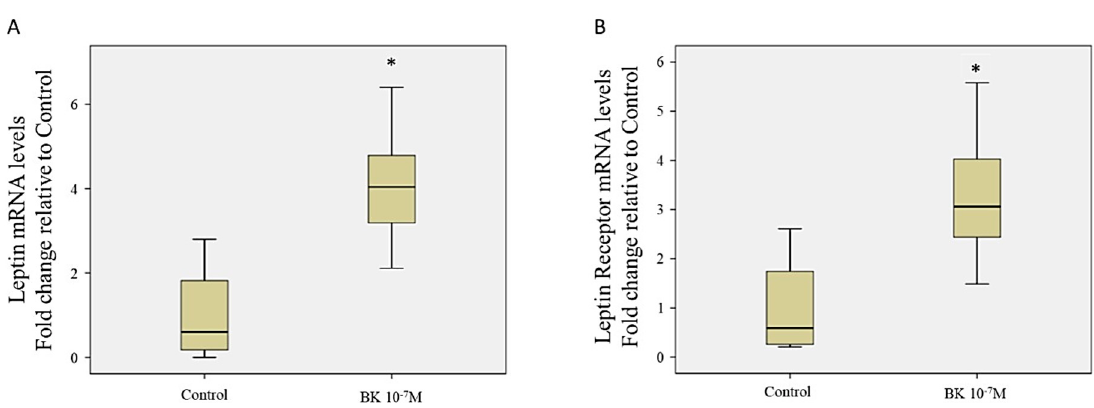
Figure 4. Assessment of leptin and leptin receptor expression. ( A ). mRNA level assessment of leptin mRNA by RT-qPCR in response to BK 24 h relative to non-stimulated controls. Boxplots are representative of 4 di ff erent repeats. ( B ). mRNA level assessment of leptin receptor mRNA by RT-qPCR in response to BK 24 h relative to non-stimulated controls. Boxplots are representative of 5 di ff erent repeats. * p < 0.05 BK vs. control.